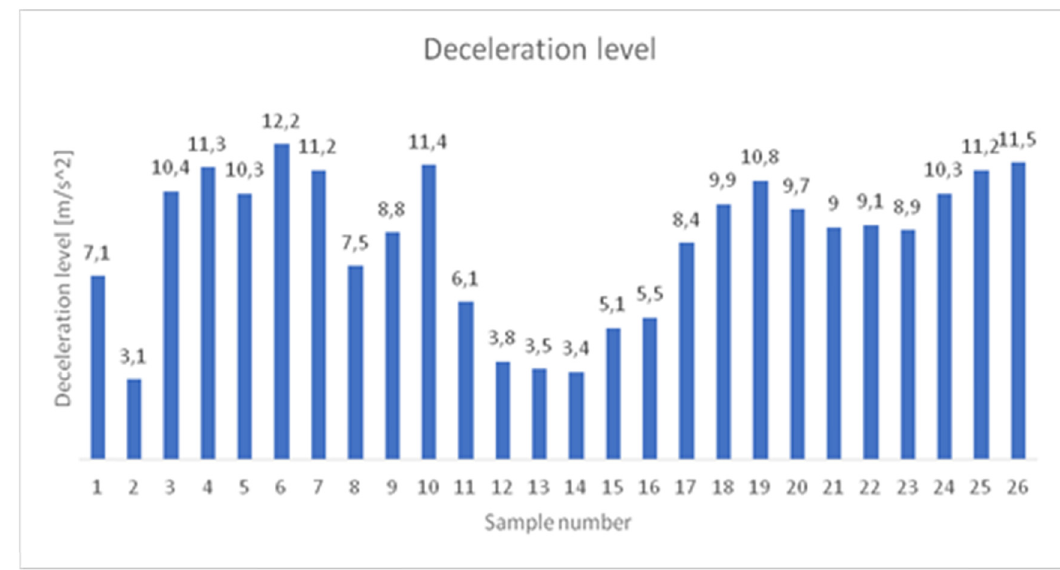
Figure 17: Maximum values of deceleration level. Source: “ authors ” own